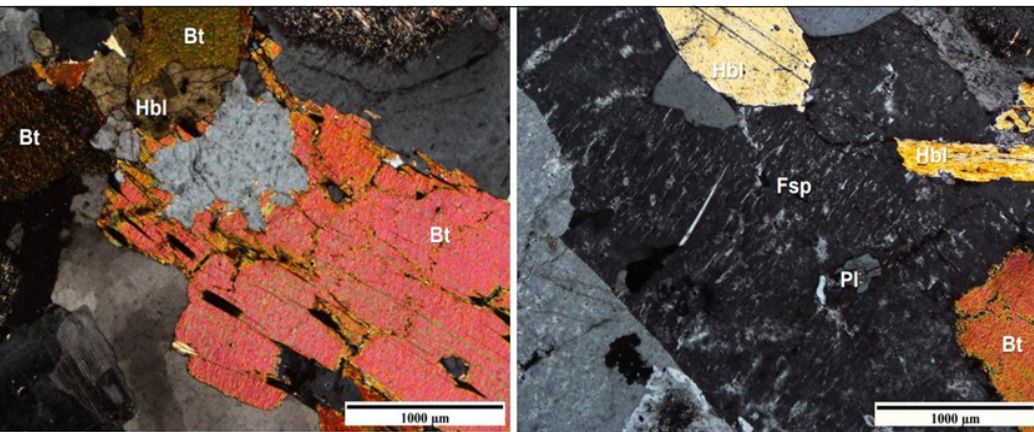
Fig. 6. Weathered second phase granite, Khangai Complex; Right photo: xenolith-bearing Bt-Hbl-granite